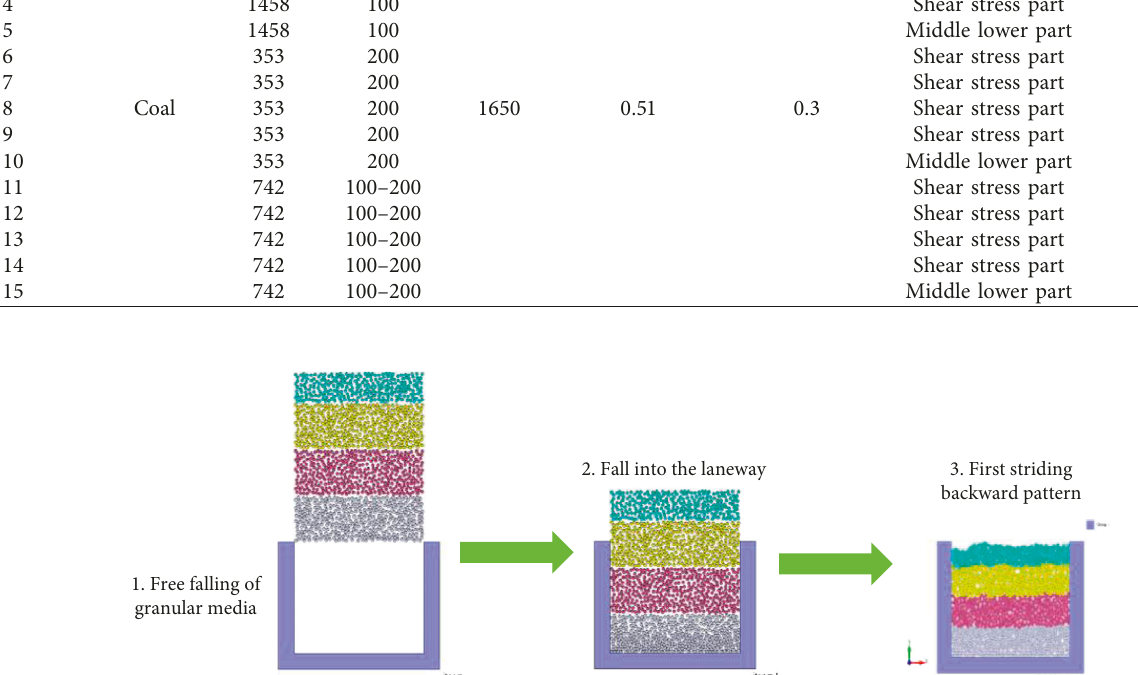
Figure 5: Particle formation process.